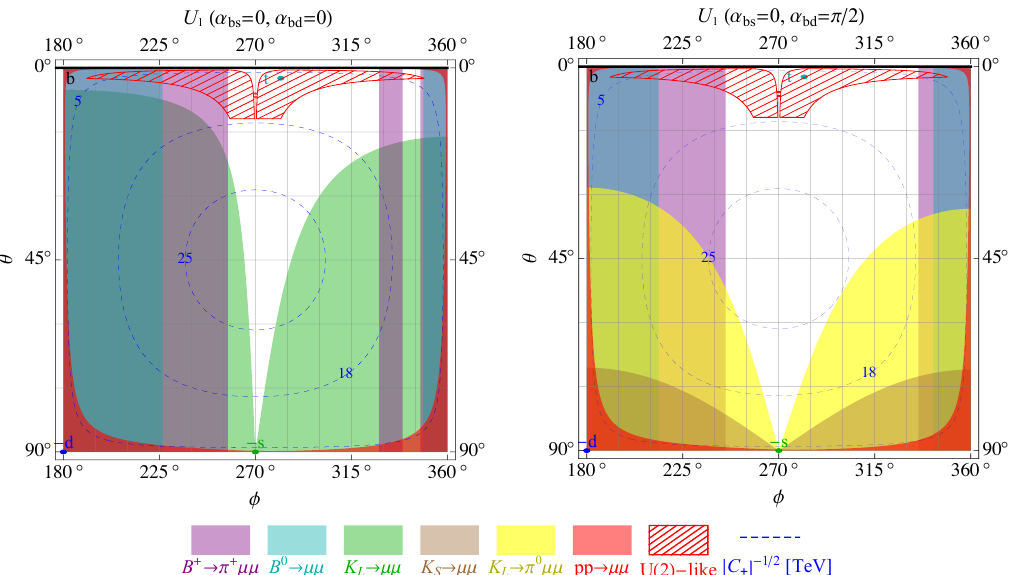
Figure 3 . Limits in the plane ( (cid:30); (cid:18) ) for the vector leptoquark U 1 and two choices of the phases (cid:11) bs and (cid:11) bd . The red region is excluded by the high- p T tail of pp ! (cid:22) + (cid:22) (cid:0) at the LHC [63]. limit on its mass, for a given value of C , can be set by requiring that the coupling (cid:12) does + p not exceed the perturbative unitarity limit j (cid:12) max j 2 = (8 (cid:25) ) = (3 3) [78]. The contours of the strongest of these two upper limits on M are shown as dashed purple lines (in TeV) in S 3 the plots of (cid:12)gure 2. The perturbativity limit is never stronger than the one from (cid:1) F = 2 processes in this scenario. More details are reported in appendix B.6. Direct searches at the LHC of pair-produced leptoquarks, on the other hand, set lower limits on its